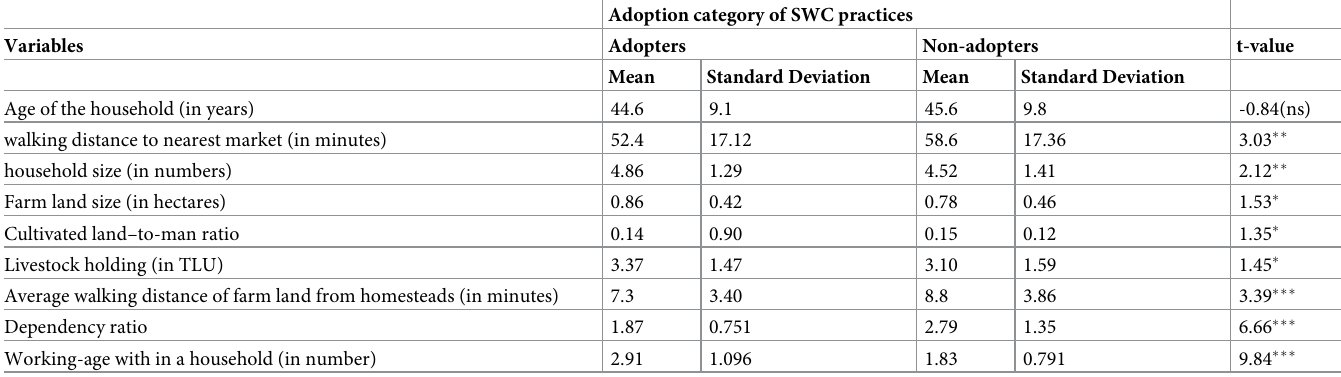
Table 2. Continuous variables differing adopters from non-adopters of SWC technologies in lege-lafto